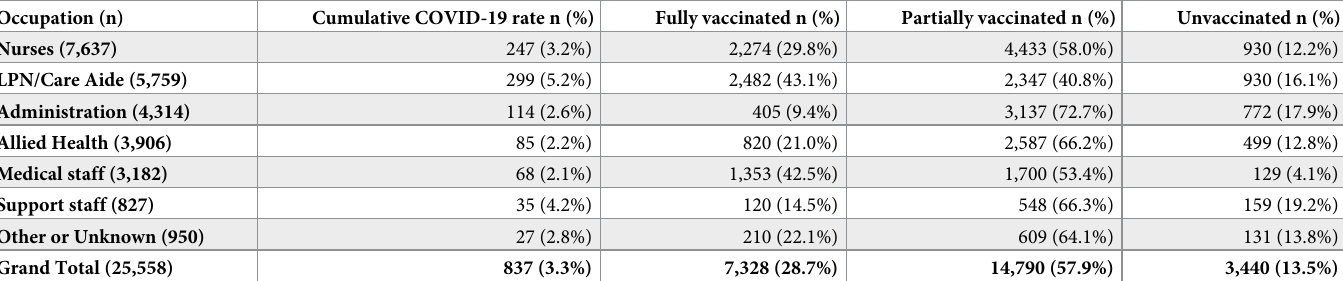
Table 1. COVID-19 infection rate and vaccine status for VCH HCWs by occupation by May 13,